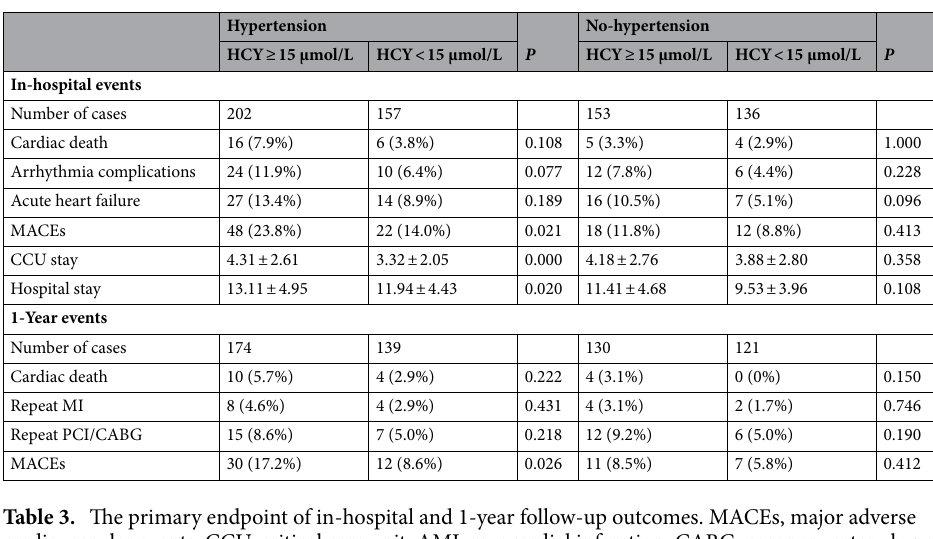
Table 3. The primary endpoint of in-hospital and 1-year follow-up outcomes. MACEs, major adverse cardiovascular events; CCU, critical care unit; AMI, myocardial infarction; CABG, coronary artery bypass grafting; PCI, percutaneous coronary intervention.